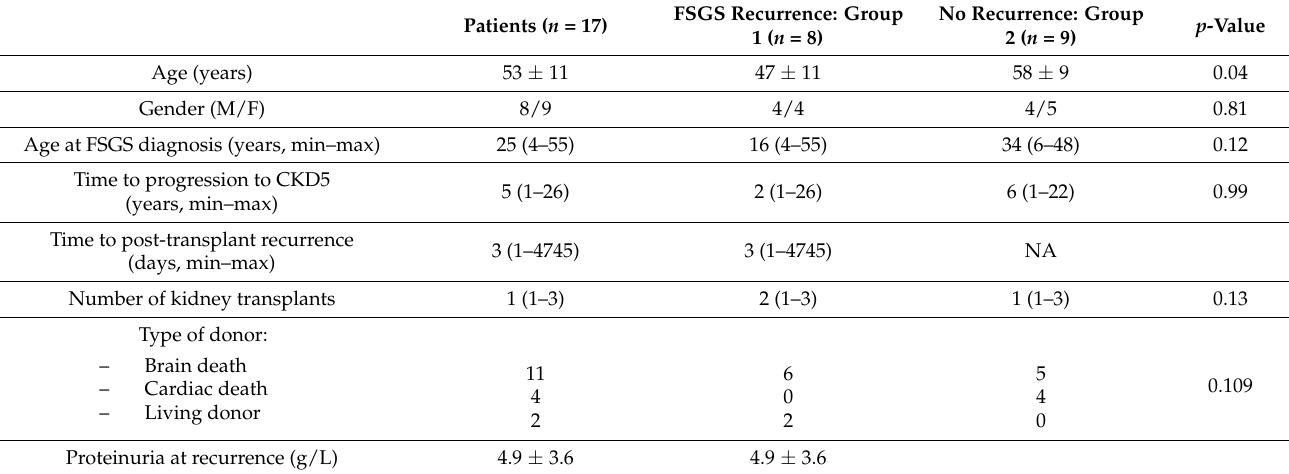
Table 1. Demographic data from the study